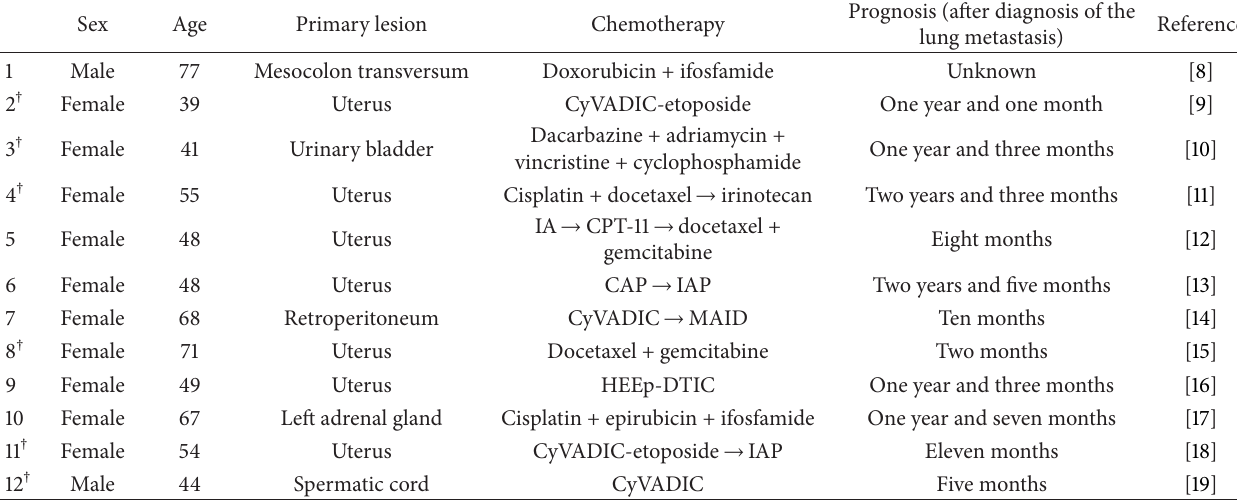
Table 2: Lung metastases from a leiomyosarcoma treated by chemotherapy alone over the last 10 years in Japan (2001–2011).